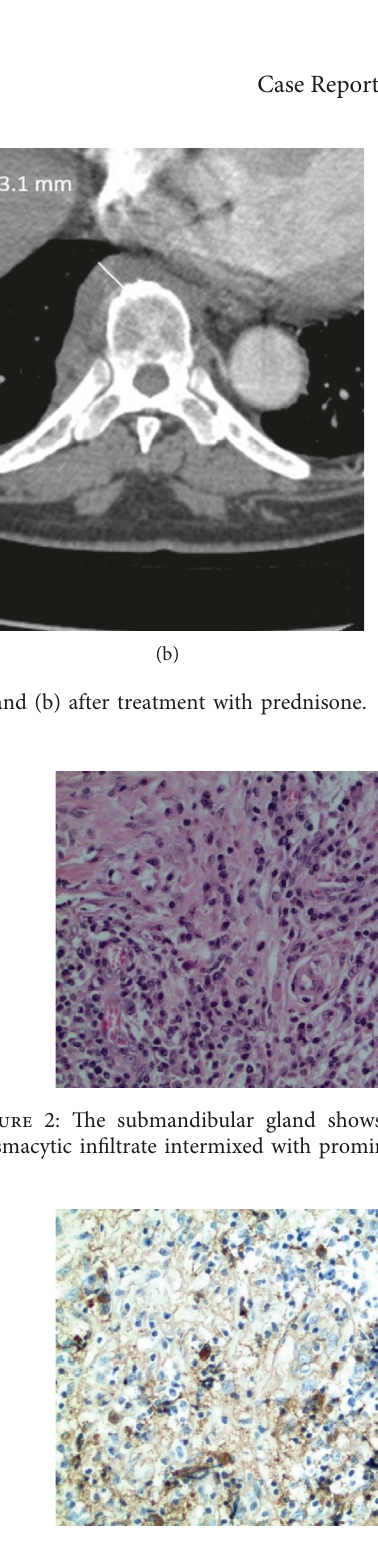
Figure 3: The paravertebral mass shows dense fibrosclerosis with increased lymphoplasmacytic infiltrates, and IgG4 plasma cells are slightly